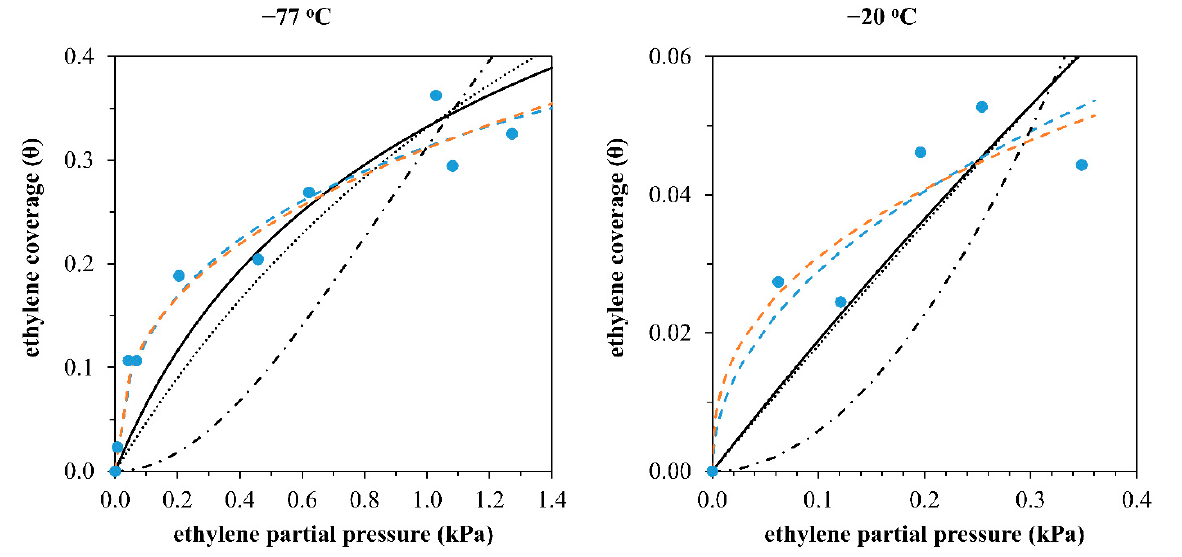
Figure 2. ( • ) Experimental ethylene coverage as a function of ethylene partial pressure at − 77 and − 20 ◦ C. Modeled ethylene coverage ( — ) with the Freundlich equation and the Langmuir equations shown in Table 1: ( . . . ) dissociation or simple adsorption over one site, ( – ) simple adsorption over two sites, ( — ) dissociation over two sites, and (- · -) association over one site. Enthalpies of adsorption of − 82.8 and − 68.8 kJ/mol were reported for ethylene coordination on [Ni 2+ -ethene] and [H + -ethene] sites, respectively [9]. This enthalpy difference ( − 14.0 kJ/mol) is less than the physisorption enthalpy of ethylene over zeolites of − 22.6 kJ/mol. The hypothesis that the catalyst surface has a low extent of heterogeneity and constant heat of adsorption with ethylene coverage is consistent with the small difference in ethylene coordination enthalpy reported in the literature for nickel and Brønsted sites.